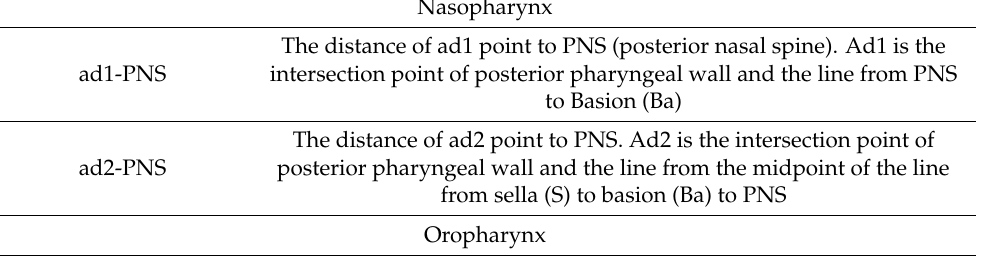
Table 1. Definitions of cephalometric measurements [7].